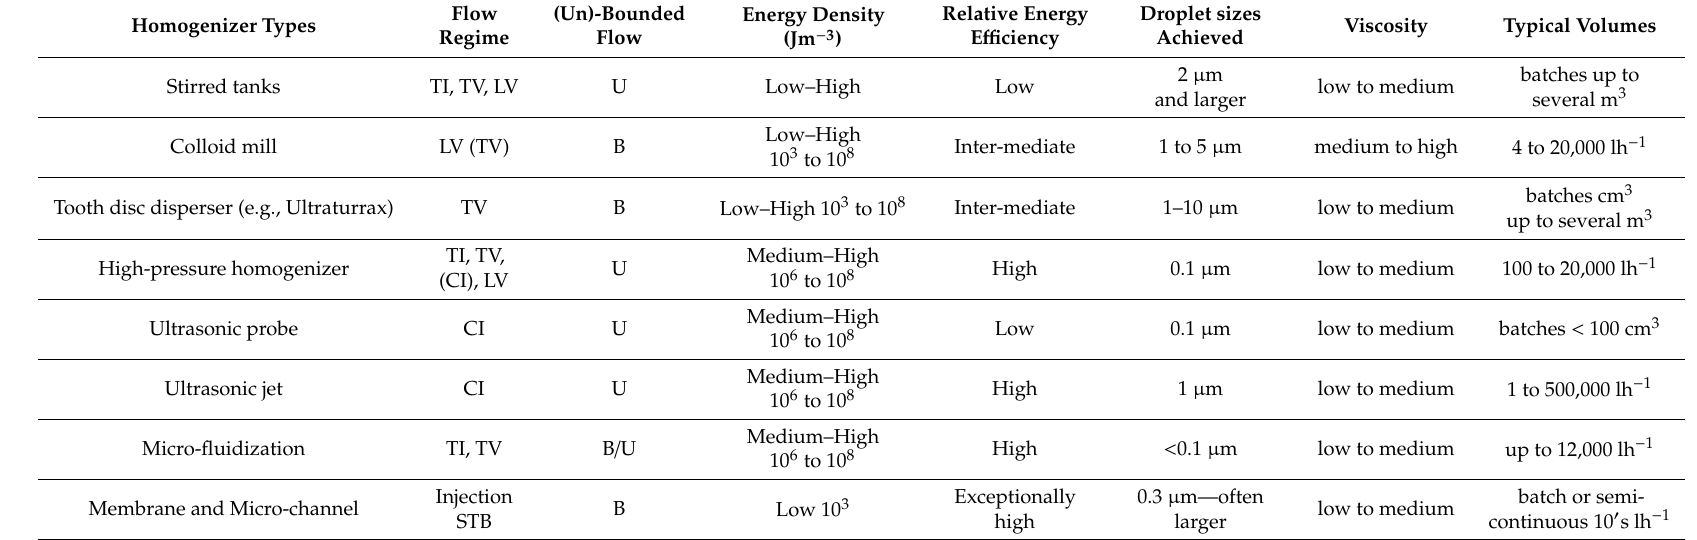
Table from Rayner [8]; reprinted with permission from CRC Press. The flow regimes are: LV = laminar–viscous, TV = turbulent–viscous, TI = turbulent–inertial, CI = cavitation–inertial, STB = spontaneous transformation based. Low viscosity = like water, medium viscosity = like cream, high viscosity = like